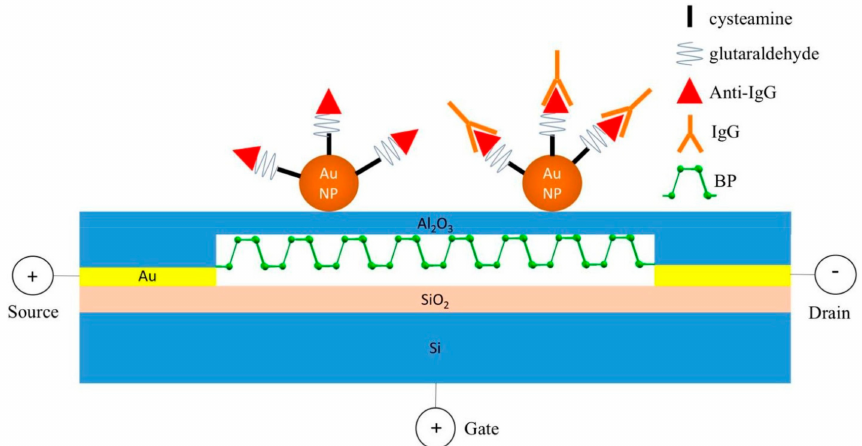
Figure 6. Fabrication of black phosphorus (BP)-FET biosensors with passivation of the Al 2 O 3 dielectric layer on the surface of exfoliated BP nanosheets to prevent them from being oxidized prior to surface modification of Au nanoparticles and probe immobilization of Anti-Immunoglobulin G (Anti-IgG) [81]. Reprinted from Biosensors and Bioelectronics, 89, Chen et al., Field-E ff ect Transistor Biosensors with Two-Dimensional Black Phosphorus Nanosheets, 505–510, Copyright 2017, with permission from